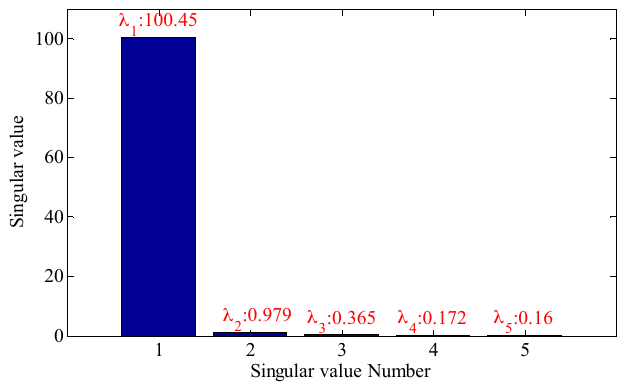
Figure 20. Singular value of the trace matrix.